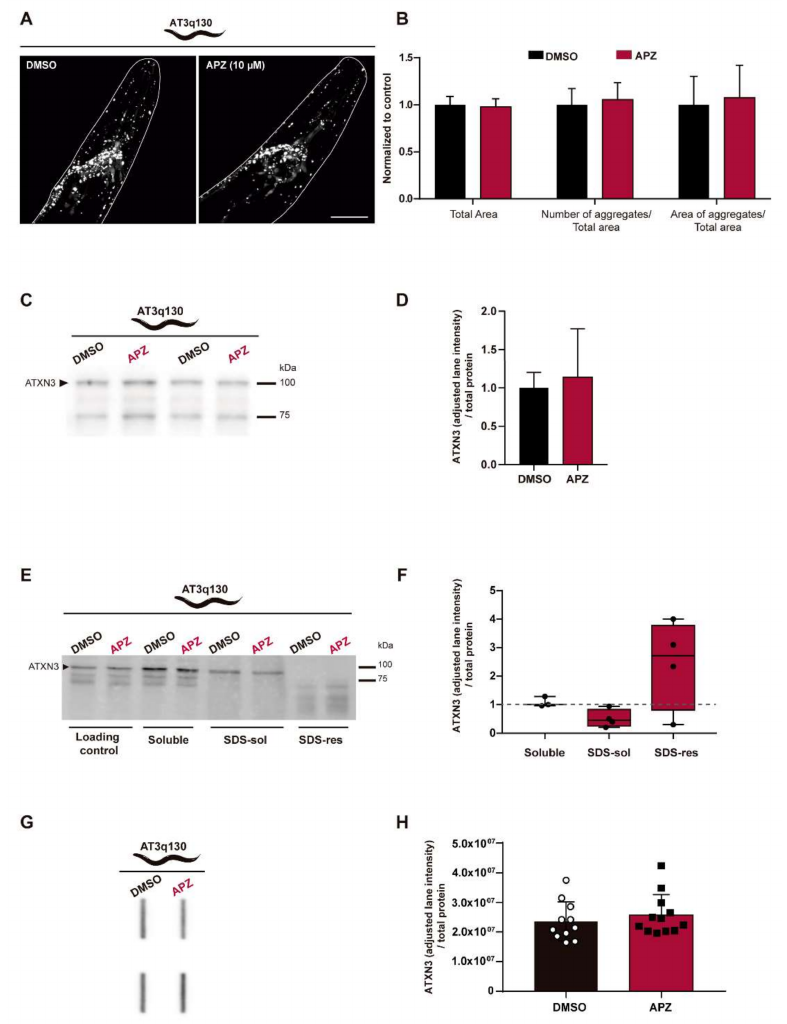
Figure 2. Aripiprazole treatment does not alter mutant ATXN3 aggregation. ( A ) Confocal microscopy images of AT3q130 worms’ heads, showing YFP-positive ATXN3 inclusions, upon treatment with DMSO or aripiprazole (10 µ M). Confocal microscopy images are representative of the three indepen- dent experiments, with at least eight animals being analyzed per condition in each experiment. Scale bar: 100 µ m. ( B ) Quantification of the number of aggregates per total area and area of aggregates per total area showed no differences on aggregation load, upon aripiprazole treatment. Data were normalized to the 1% DMSO control. ( C ) Total steady-state levels of ATXN3 protein upon aripiprazole treatment were evaluated by Western blot analysis. ( D ) Total steady-state levels of ATXN3 protein were not altered upon aripiprazole treatment. Values were normalized for the total protein staining and to the 1% DMSO control. ( E ) Western blot depicting the biochemical fractionation blot with the soluble (soluble in Triton X-100; soluble), SDS-soluble (soluble in SDS; SDS-sol) and SDS-resistant (insoluble in SDS; SDS-res) fractions. ( F ) No statistically significant changes were found in ATXN3 aggregation measured by biochemical fractionation. Dashed line represents DMSO control. Values were corrected for total protein and ratio of ATXN3 corrected (to total protein) divided by ATXN3 values of the DMSO are represented. ( G ) Filter retardation assay blot. ( H ) No significant differences were found in ATXN3 aggregates retention after aripiprazole treatment. ATXN3 signals in membrane were normalized to the total protein signals (AzureRed stained gel). For confocal microscopy live imaging: ( n = 26 − 32, ± SD—pool of 3 individual experiments), (independent sample t -test). For ATXN3 steady-state levels: ( n = 6 ± SD) (independent sample t -test). For biochemical fractionation: ( n = 3 − 4, Q1 − Q2 − Q3), (one sample t -test vs value 1). For filter retardation assay: ( n = 11 − 12 ± SD) (independent sample t -test). APZ—aripiprazole; DMSO –